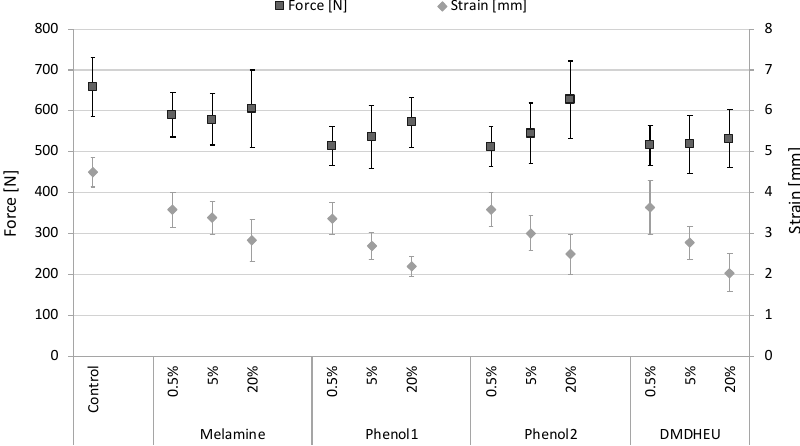
Figure 4. Maximum force (N) and deflection (mm) in impact bending depending on modification agent and concentration (mean and SD).